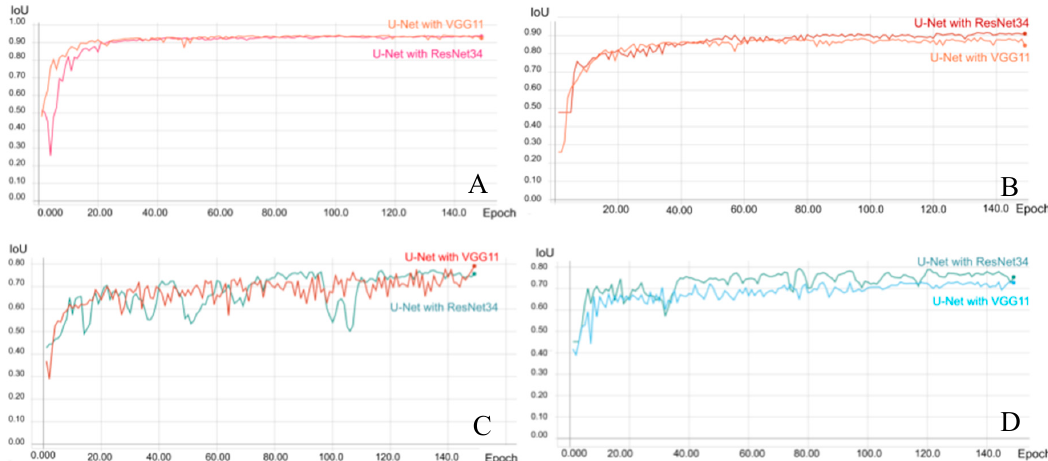
Figure 2. Performance and validation curves for each architecture of the trained convolutional neural network (CNN) models (VGG11 and Resnet34) on MRI. The prediction (intersection over union) score of CNN models in reading the uterus on contrast-enhanced T1w ( A ) and T2w ( B ). The prediction score of CNN models in reading endometrium on contrast-enhanced T1w ( C ) and T2w ( D ).